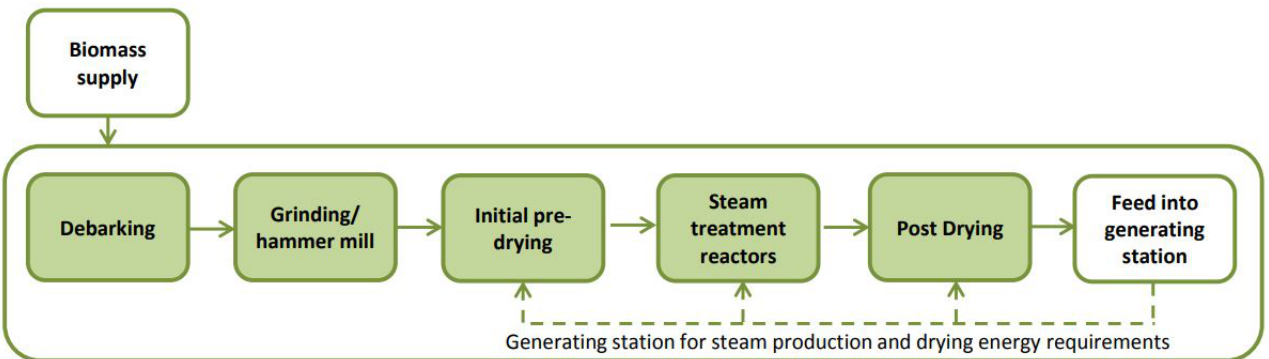
Figure 3. Process schematics of the steam-explosion